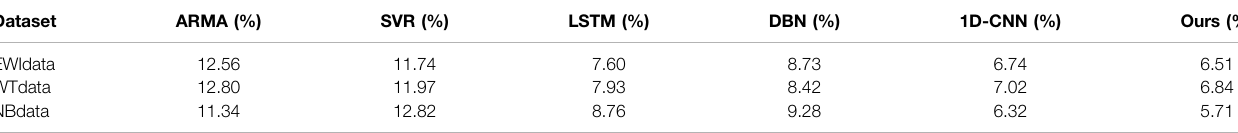
TABLE 3 | Average MAPE of different prediction models on different datasets.